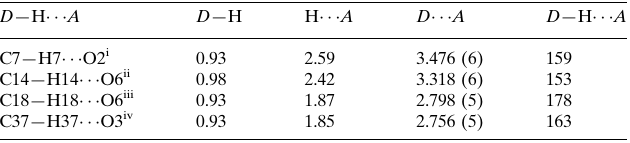
Hydrogen-bond geometry (A˚ , (cid:5) ).